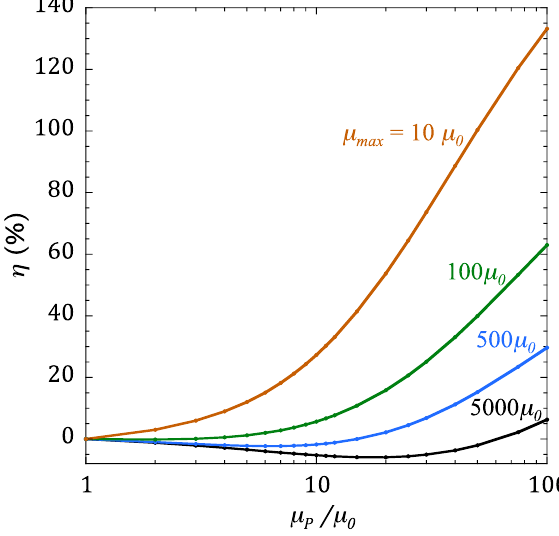
Figure 6. Relative change of the MI max response, experienced by sensors with di ff erent MI performance (di ff erent values of µ max ) when a system of MNPs with increasing concentration is placed on top.